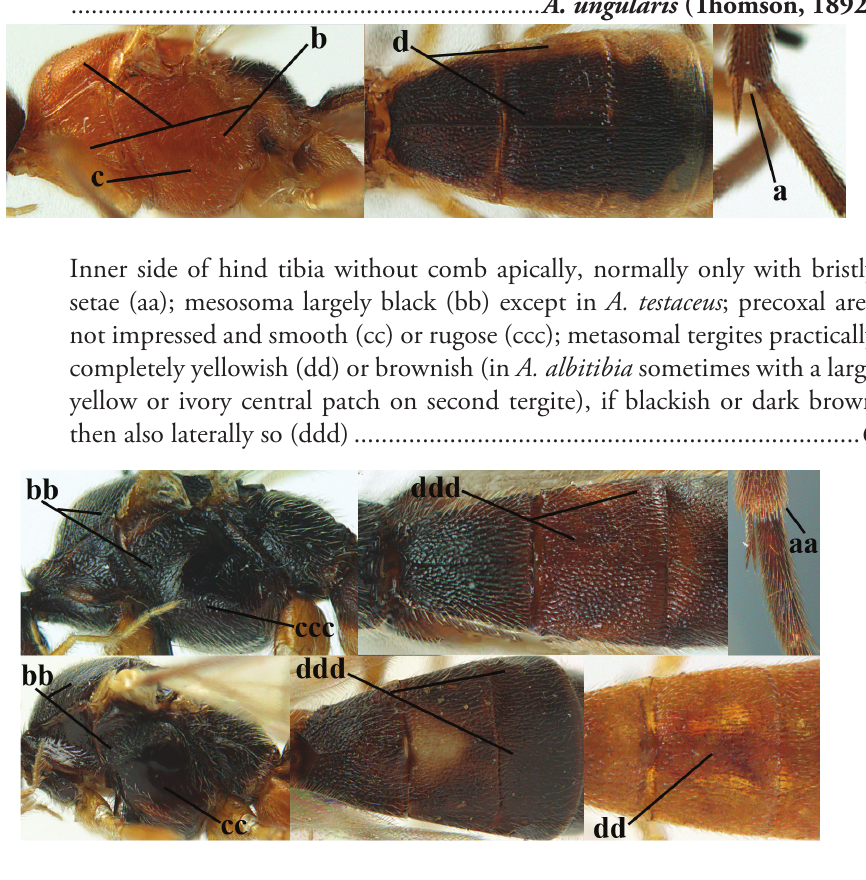
Inner side of hind tibia with comb of whitish bristles apically (a); mesosoma (except propodeum and metapleuron) largely yellowish or yellowish orange (b); precoxal area impressed medially and finely crenulate (c); metasoma dark brown or blackish medially and largely pale yellow laterally (d) ...................... ...................................................................... A. ungularis (Thomson, 1892)